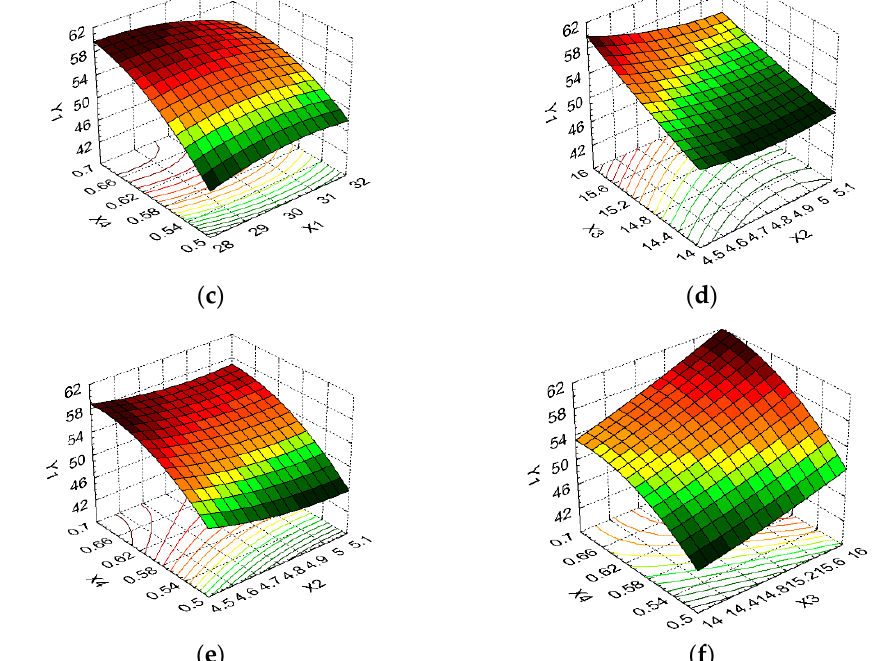
Figure 5. 3D response surface and contour plot showing the effects of different cultivation conditions on the wet biomass response (Y 1 ): ( a ) temperature (X 1 ) and pH (X 2 ); ( b ) temperature (X 1 ) and carbon source (X 3 ); ( c ) temperature (X 1 ) and nitrogen source (X 4 ); ( d ) pH (X 2 ) and carbon source (X 3 ); ( e ) pH (X 2 ) and nitrogen source (X 4 ); and ( f ) carbon source (X 3 ) and nitrogen source (X 4 ).